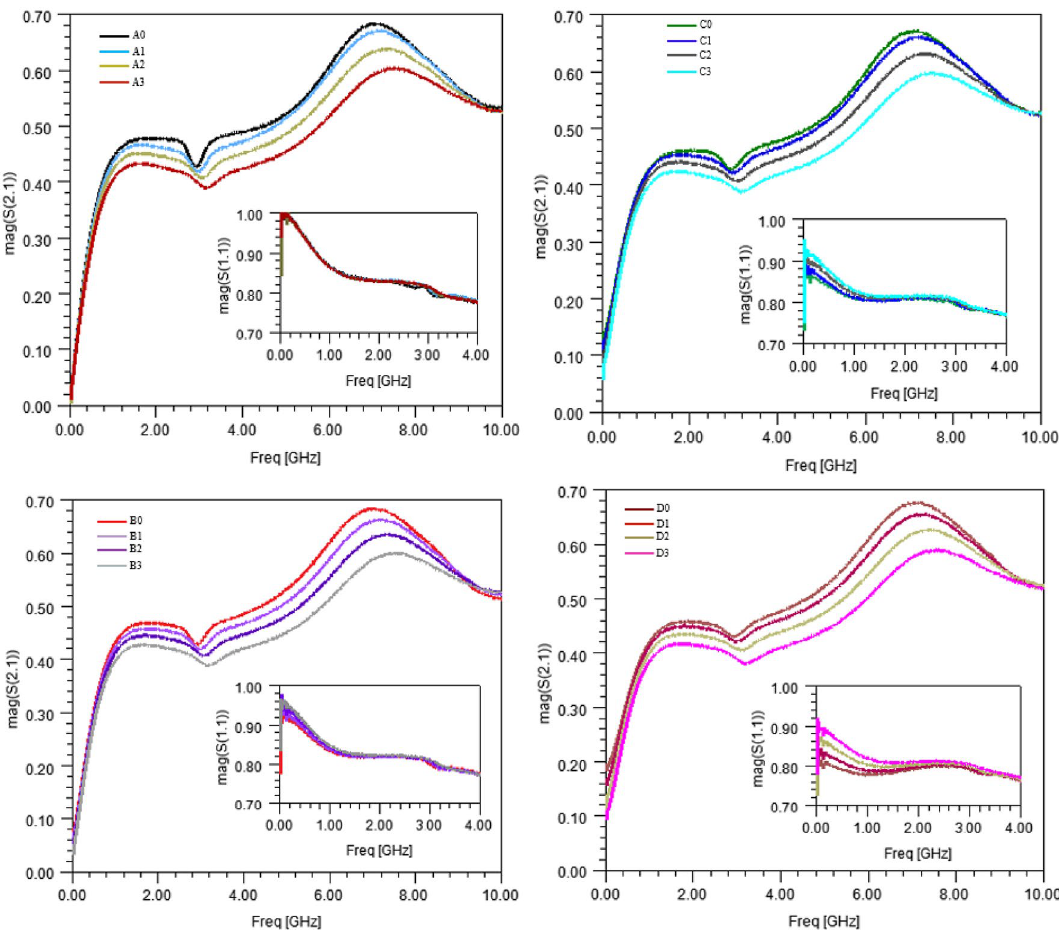
Figure 17. Measured transmitted (S21) and reflected (S11) parameters of the sensor with various samples.